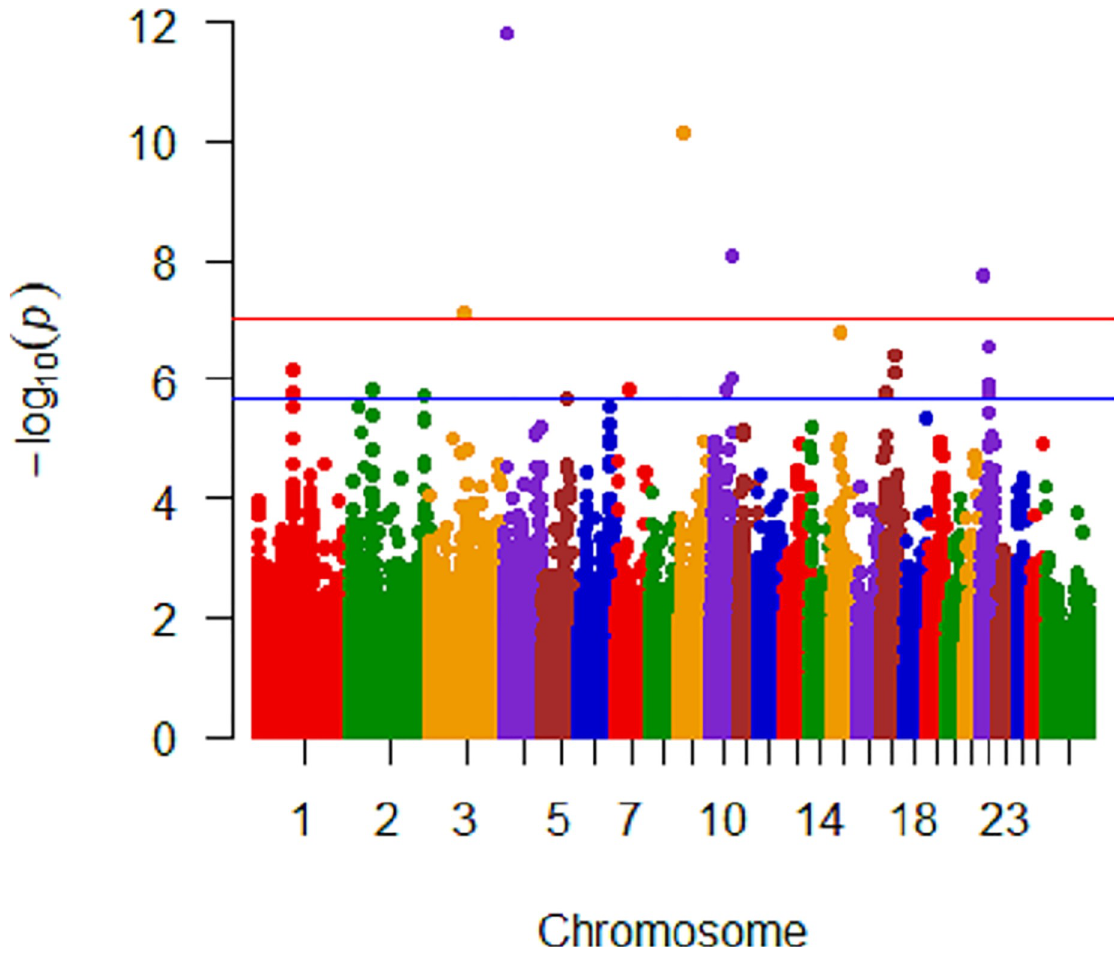
Fig 4. Manhattan plot of Rambouillet analysis with untransformed M . ovipneumoniae mean DNA copy number. Significant SNPs are on chromosomes 3, 4, 9, 10, and 22. Genome significant line is red and genome suggestive line is blue.